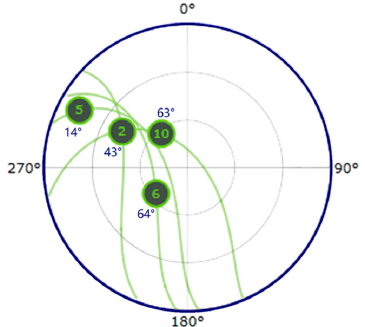
Figure 6. Skyplot at 22:00 UTC on 9th September, 2014 showing the in-view GPS satellites available and the respective elevation angles.